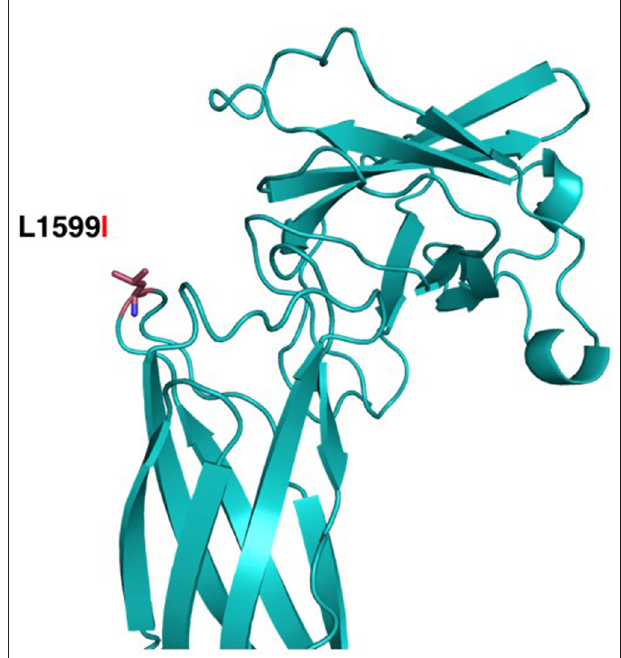
FIGURE 7 | Structural modeling of Leu1599Ile in SMCHD1. The mutation is located closer to the Flexible Hinge Domain (aa 1719–1847). The substitution of Leu1599 (red sticks) for the Isoleucine is a conservative replacement pointing to the outside of the structure, which might not compromise the stability of the structure of the protein